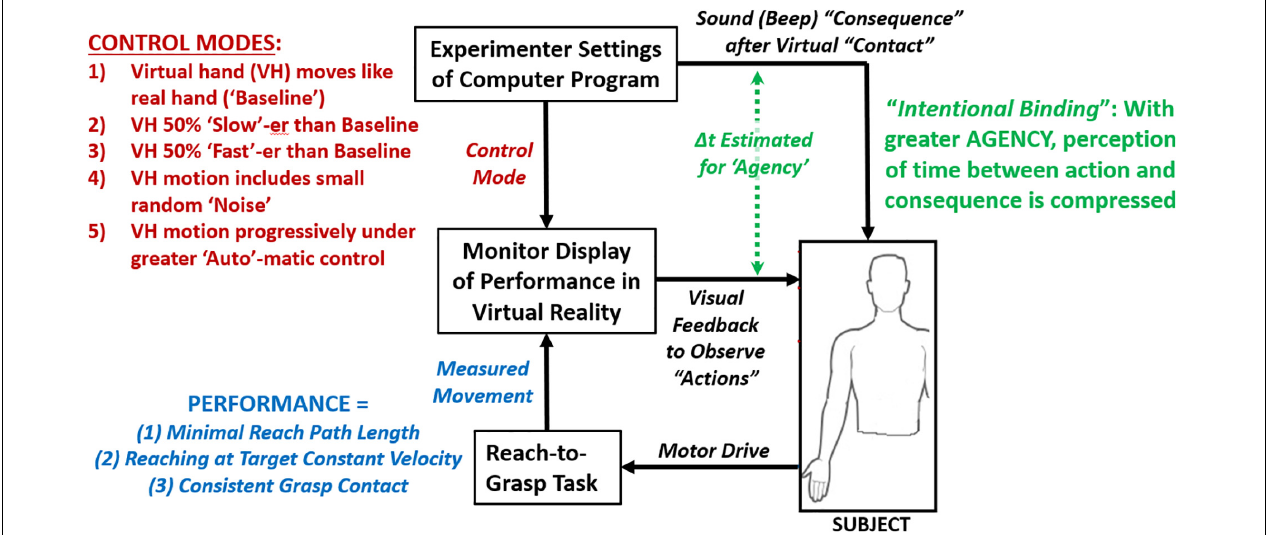
FIGURE 1 | Flow diagram of experiment of participant performing reach-to-grasp task under varying control modes of displayed virtual hand while assessing performance and